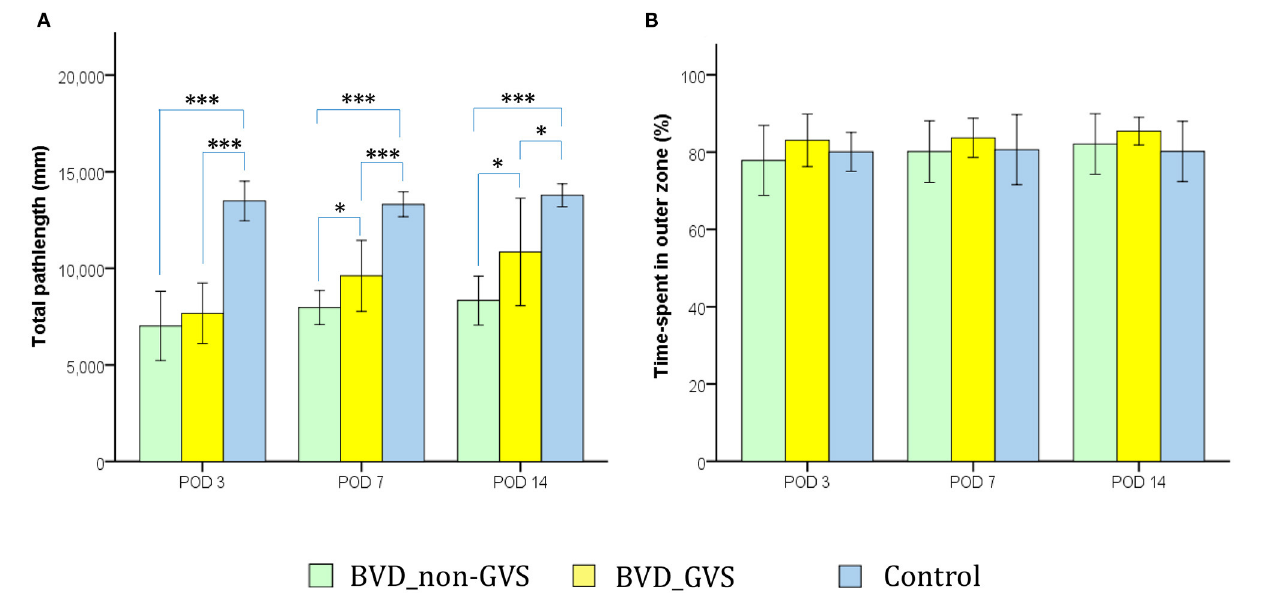
FIGURE 2 | Evaluation of the locomotor activity of mice in an open-field (OF) task. Locomotion impairment was indicated by a significant decrease in the total path length. The values of the BVD_non-GVS group were lower than those of the control group on PODs 3 ( p < 0.001, Bonferroni test), 7 ( p < 0.001, Bonferroni test), and 14 ( p < 0.001, Bonferroni test). GVS improved the total path length during OF activity on PODs 7 ( p = 0.031, LSD test) and 14 ( p = 0.027, LSD test) (A) . The percentage of time spent in the outer zone, which is an indicator of anxiety, did not differ among the three groups (B) . Values are indicated as the mean ± SD. Statistical significances were calculated using one-way ANOVA with post-hoc tests. *Significant differences between two groups: * p < 0.05; *** p <